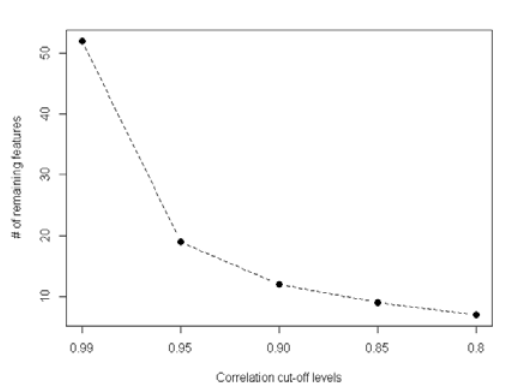
Figure 3 - Number of remaining features by level of correlation after filtering process.